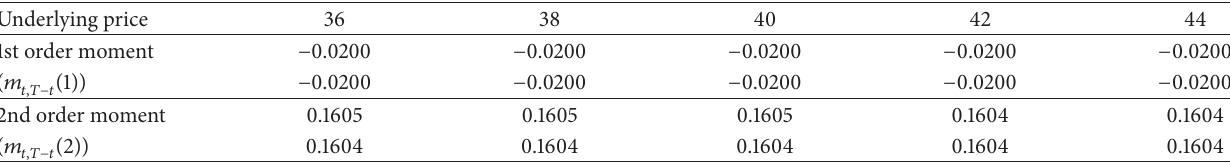
Table 1: Recovered moments and their theoretical values for a range of initial underlying prices (𝑆 𝑡 = 36, 38, 40, 42, 44) in the